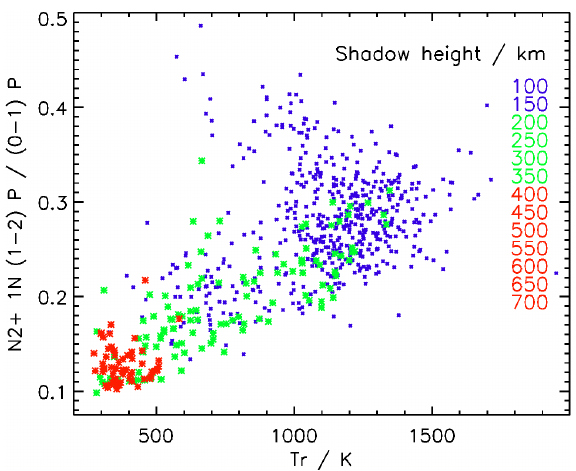
Fig. 13. The ratio of N + temperature and shadow height (excluding screening height) for